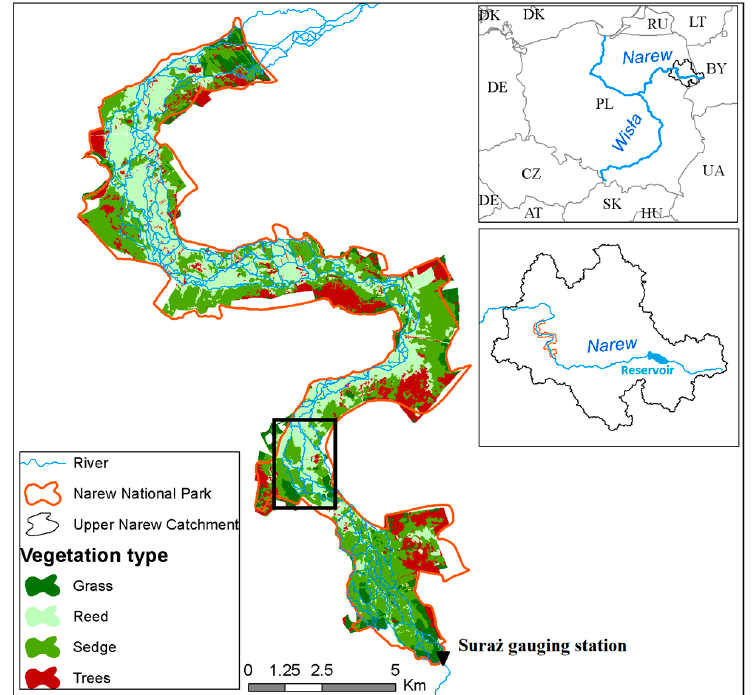
Figure 1. Case study location with vegetation map. Black box indicates a stretch of the stream used in modeling procedure.